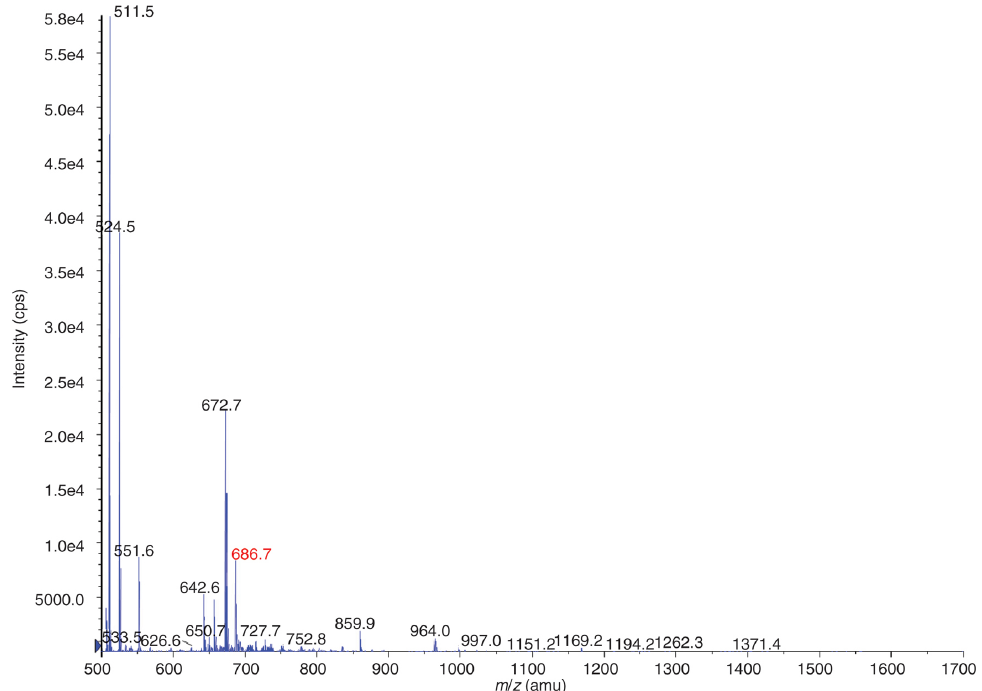
Figure 3: ESI-MS/MS profile of a precursor ion scan of m/z 175 in positive ion mode, scan range m/z 475 – 1700, performed on the PMP-derivatized urine from a